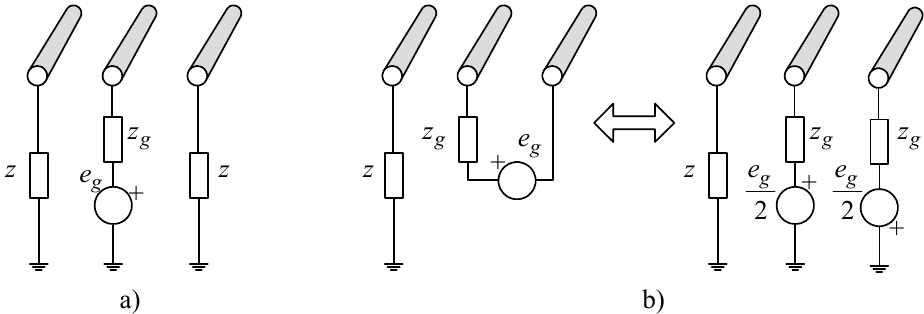
Figure 3. Principal schemes of ( a ) a phase to ground coupling and, ( b ) a phase to phase coupling. Voltages at the transmitting and receiving ends of a HV power line are correlated with voltage transfer matrix T . Corresponding currents are calculated using termination admittances at both power-line ends, denoted with matrices Y g and Y L